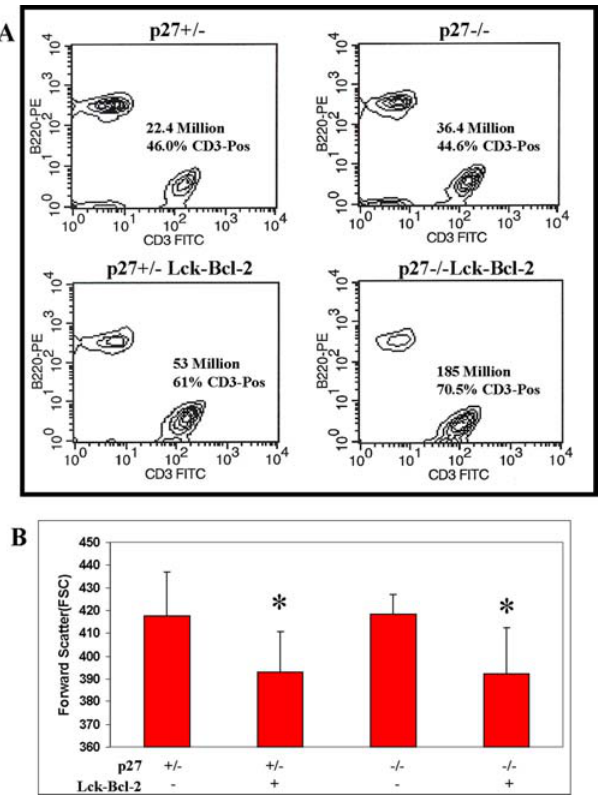
Figure 2. Splenic T cell hyperplasia and T cell size in p27 2 / 2 Lck-Bcl-2 mice. A) Total splenic cells from mice of the indicated genotypes were isolated and stained with anti-B220-PE and anti-CD3- FITC antibodies as described in the Materials and Methods. The percentage of CD3-positive cells and the total number of splenic T cells (total # of splenic cells X %CD3) is shown. The data are representative of at least three mice from each genotype. B) The Mean Forward Scatter of CD3 positive splenic T cells was determined by staining with an anti- CD3 antibody as described in the Materials and Methods. The Mean 6 SD of at least 5 mice is shown for the genotypes indicated. * P , 0.01 versus both the p27 + / 2 and p27 2 / 2 mice using the unpaired Students T test. The p27 + / 2 Lck-Bcl-2 mice were not significantly different than the P27 2 / 2 Lck-Bcl-2 mice (P=0.89).